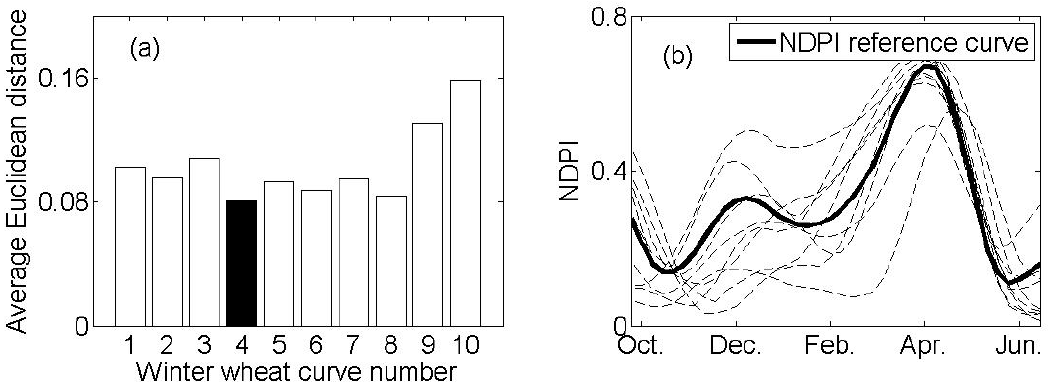
Figure 7. ( a ) Average Euclidean distance of each winter wheat NDPI curve from the other curves; Curve No. 4 has the minimum distance (filled-in black bar). ( b ) NDPI curves of ten winter wheat samples and the reference one.